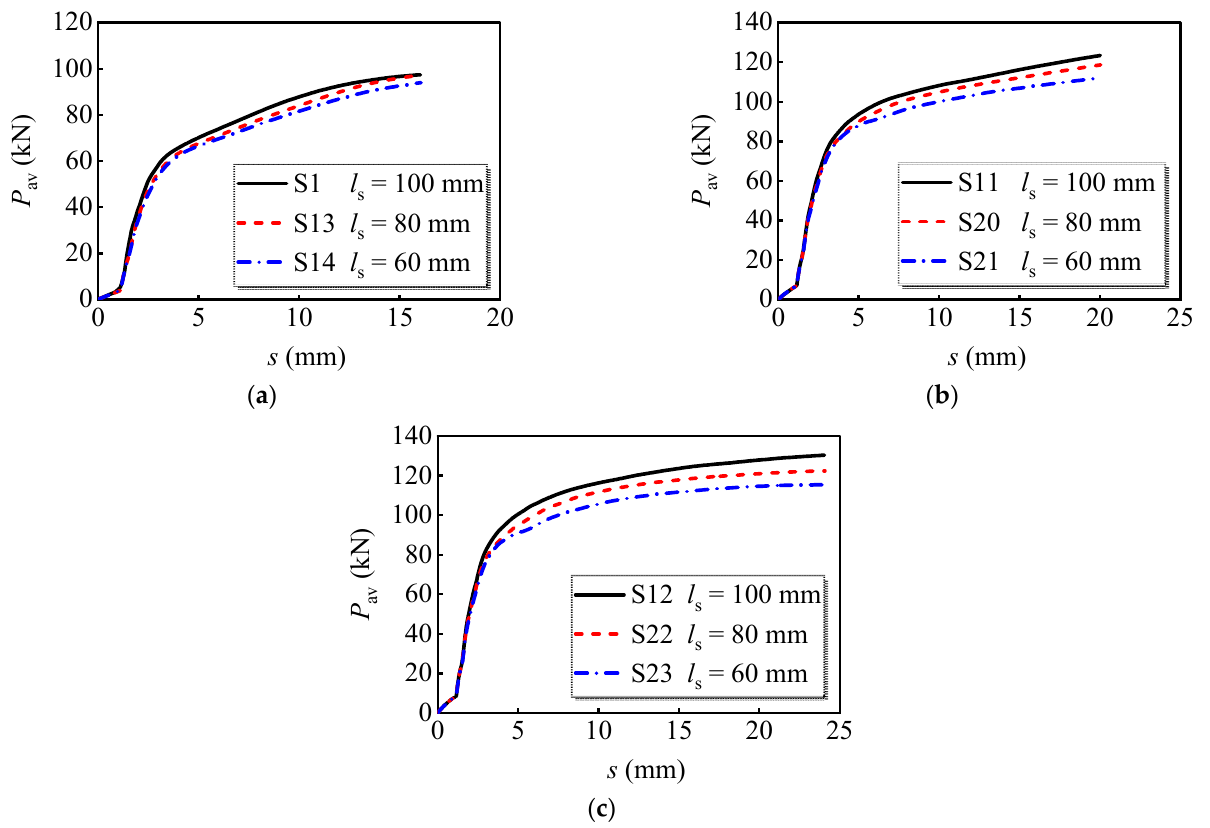
Figure 15. Average load versus slip curves of models with different longitudinal bolt spacing: ( a ) d bolt =16 mm; ( b ) d bolt =20 mm; ( c ) d bolt =24 mm.